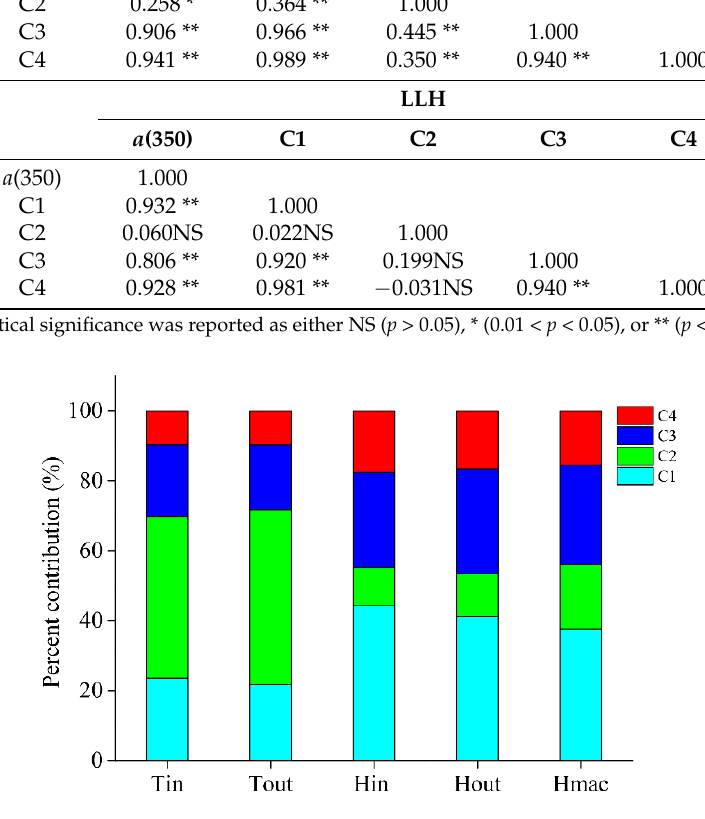
Figure 8. Average contributions to the total CDOM fluorescence intensities (in %) of the four PARAFAC components in the interior section of littoral zones of Lakes Taihu and Hongze. The standard deviation of individual CDOM fluorescence intensity in each section was lower than 10%.